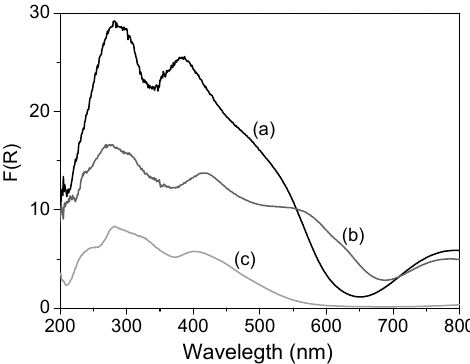
Figure 1. X-ray patterns of as-synthesized hybrid copper perovskites powders: a ) MA 2 CuCl 2 Br 2 and b ) MA 2 CuCl 0.5 Br 3.5 .